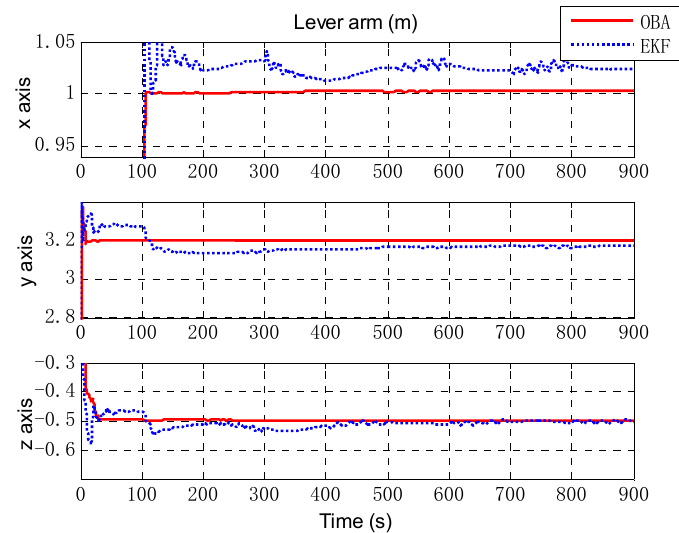
Figure 10. The estimation of lever arm. The red solid line denotes the estimation by OBA, and the blue dashed line denotes the estimation by EKF. The three figures are the lever arm of x axis, y axis and z axis respectively. Table 2. The estimate results of angular motion simulation.